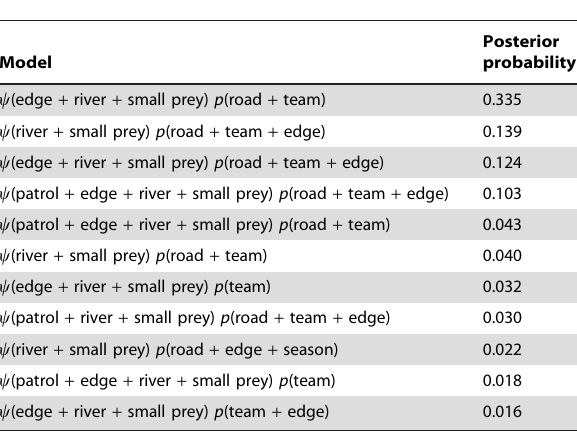
Table 4. Posterior model probabilities for the top 11 models that had 90% of the posterior support across all candidate models for community-level effects on carnivore occurrence ( y ) and detection ( p ), as estimated from the mixture modeling approach to model selection (53 additional models appeared in the posterior sample but all with probabilities ,